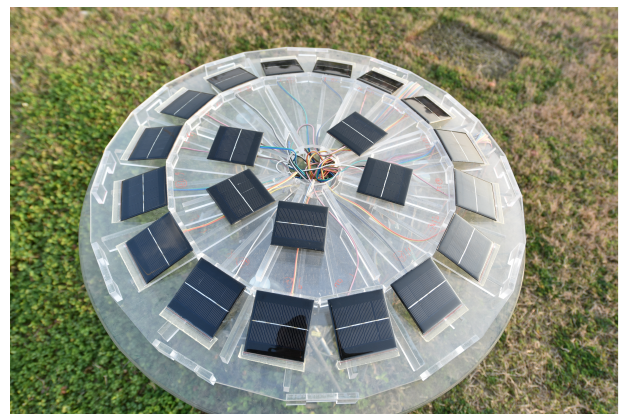
Figure 6. Regular 16-pyramid sun sensors. Table 3. The configurations of seven arrays with their M , β and α 0 . Black dots indicate the solar panels being used in each